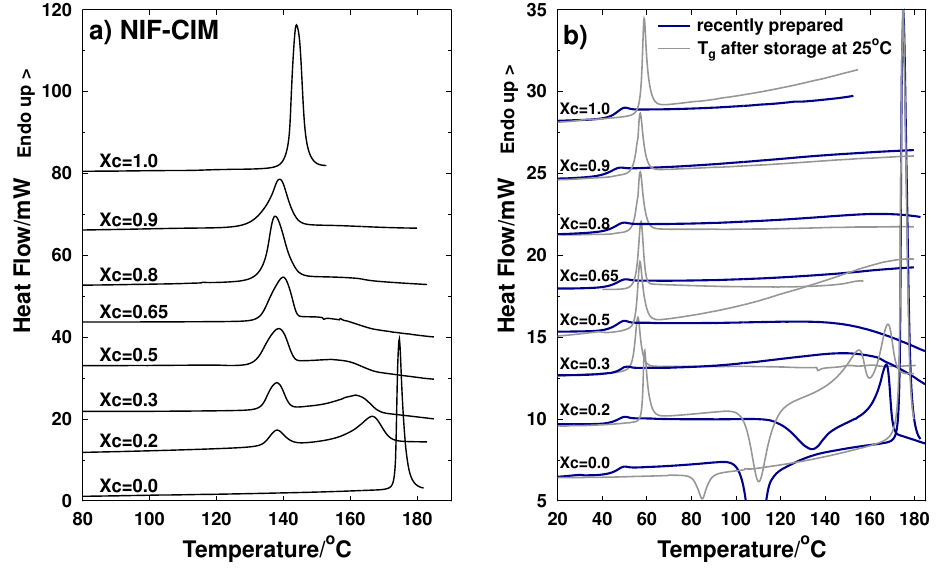
Figure 2. Thermograms of the NIF-CIM binary system obtained by Differential Scanning Calorimetry (DSC). The mole fractions are expressed in terms of cimetidine ( X c ) ( a ) crystalline samples ( b ) amorphous samples: plots with blue thick lines correspond to the measurement of the glass transition temperature performed immediately after the quenching of the molten sample. Thin gray lines correspond to the measurements performed after 133 days of storage at 25 ◦ C. (except for samples X c = 0.3 and X c = 0.65 that correspond to 80 days and 40 days of storage, respectively). Heating rate was 10 ◦ C/min in all